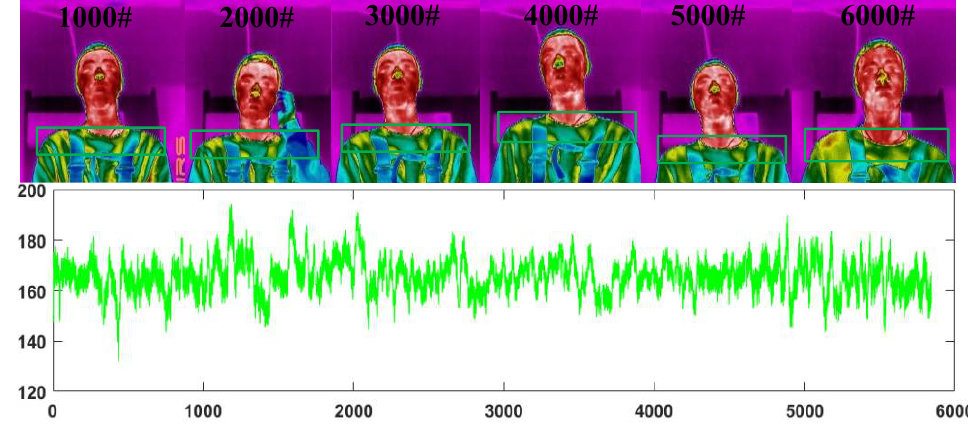
Figure 1. The top row shows the shoulder tracking results, and the bottom row illustrates its horizontal position change during running.